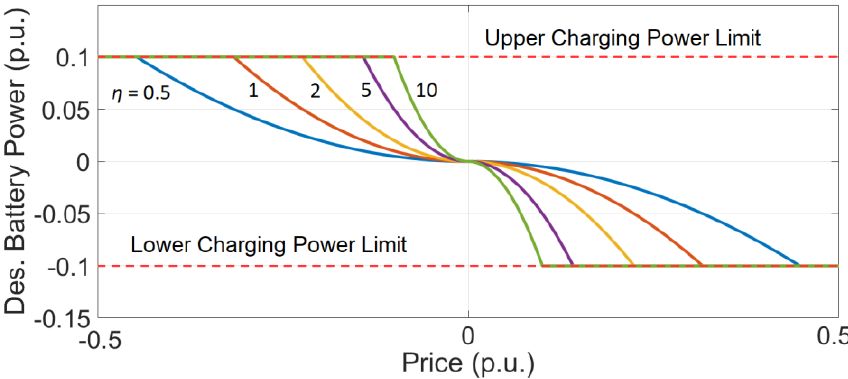
Figure 14. Desired battery power vs. electricity price for the different values of 𝜂 .